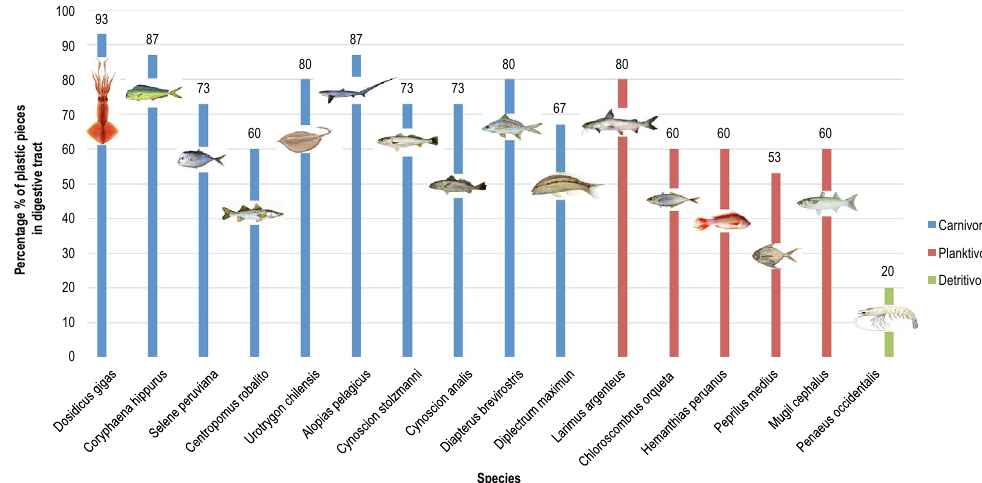
Figure 3. Prevalence of microplastic particles in the digestive track of marine species. Microplastic particles found in 16 different marine species of human consumption that were bought in the most representative ports in all four provinces (Manabí, El Oro, Esmeraldas and Santa Elena) in the Pacific coast of Ecuador were quantified. Marine organisms were categorized by their feeding behaviour: carnivorous, planktivory, and detritivore. Fifteen specimens (n = 15) were taken per each of the 16 species